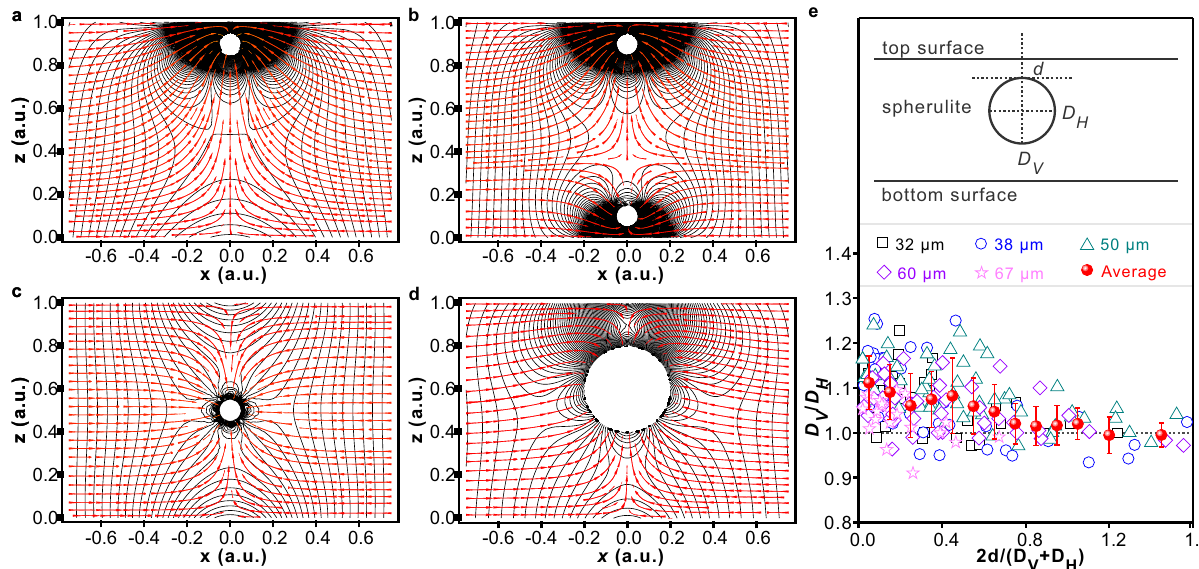
Fig. 6 2D numerical simulation of fl ow and pressure around growing spherulites and the resulting spherulite elongation. a – d In the 6 × 1 2D simulation box each spherulite is represented by a circular boundary with a constant in fl ow rate, located at different positions between the top and bottom boundaries, representing the glass plates. Only the central portion of the box is shown. Red arrows = fl ow lines, black lines = isobars. a , One spherulite growing close to the top surface. b Two spherulites growing simultaneously at opposite (top and bottom) surfaces. To represent a situation where the top spherulite nucleated earlier and is larger, hence consuming more molten polymer, its in fl ow rate is three times that of the bottom spherulite. c One spherulite grows in the middle of the cell. d One spherulite approaches the top surface. The negative pressure between surfaces of the substrate and the spherulite increases as their distance d decreases; this is particularly clear above the spherulite in ( d ). e Aspect ratio of spherulite of dye-labeled neat PLA vs . distance from the nearest glass surface for different sample thicknesses; empty symbols = experimental, red balloons = average. As indicated by the inset, D V and D H are diameters along z and in xy plane, respectively. Error bars correspond to standard